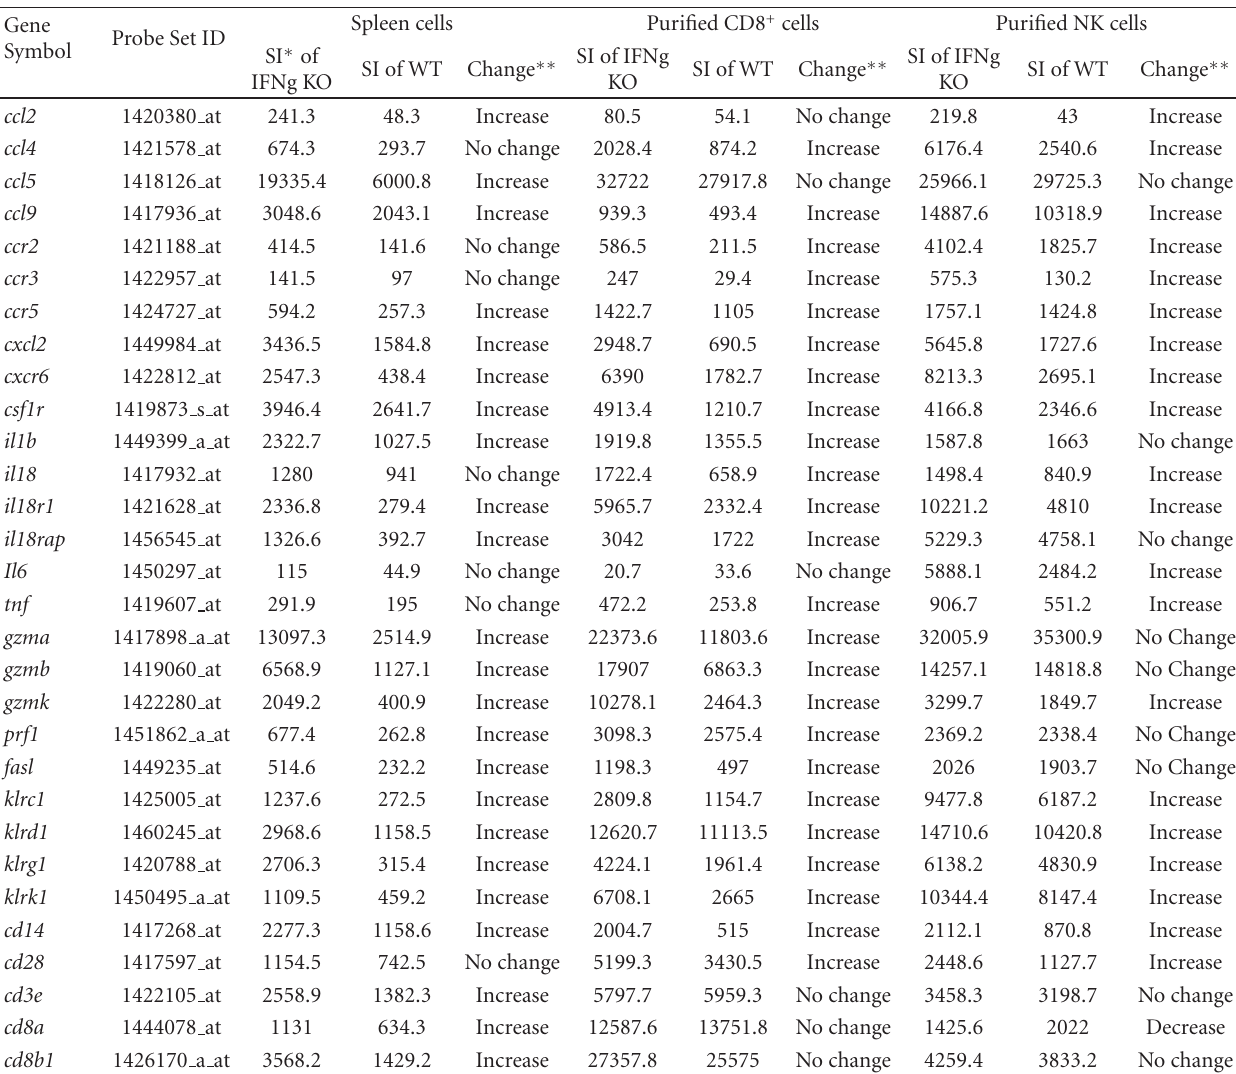
Table 2: Signal intensities of some characteristic genes in spleen cells, purified CD8 + and NK cells from 6-week Schistosoma japonicum - infected